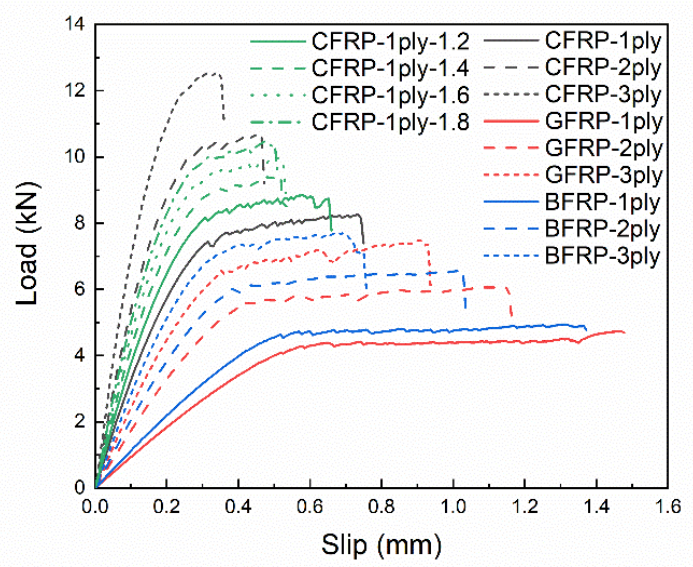
Figure 16. Load-slip curves with different fiber reinforced polymer (FRP) stiffness.